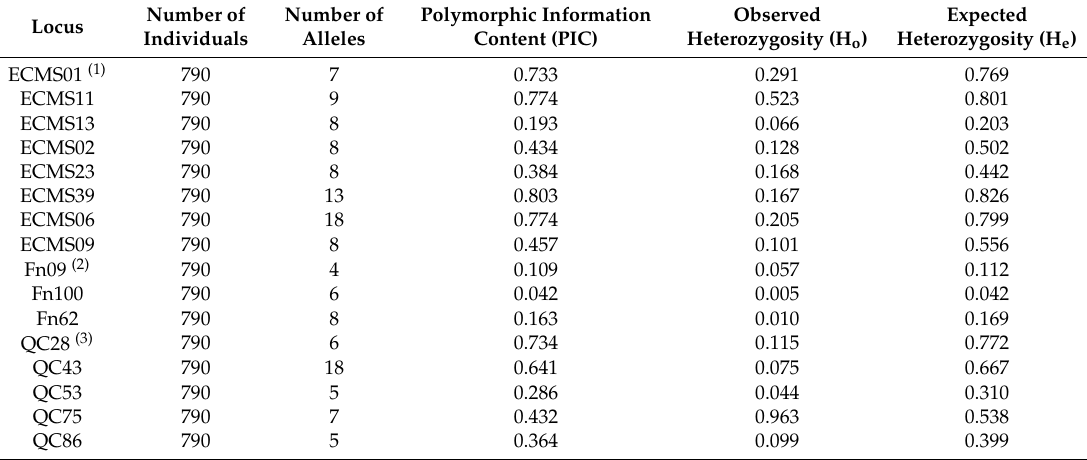
Table 2. The marker name, the total number of analyzed plants, the number of distinct alleles, the polymorphic information content (PIC), observed (H o ) and expected heterozygosity (H e ) is presented.